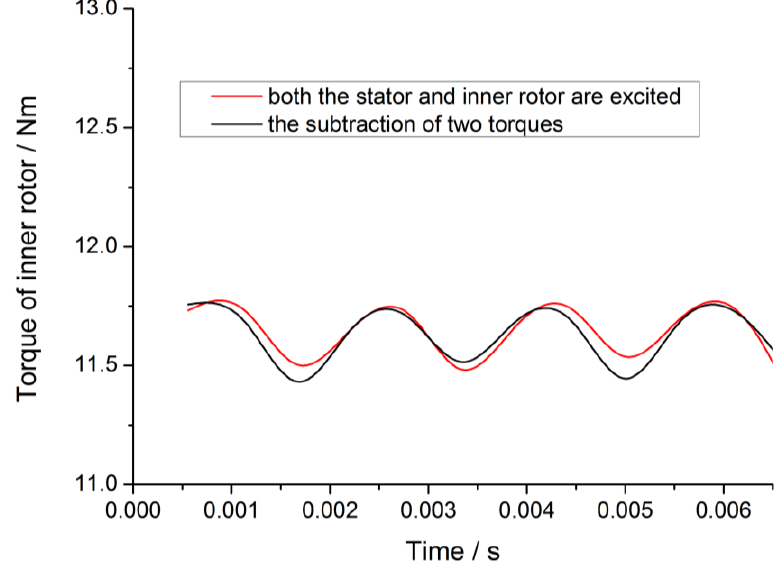
Figure 23. The torque waveforms comparison of the inner rotor in different